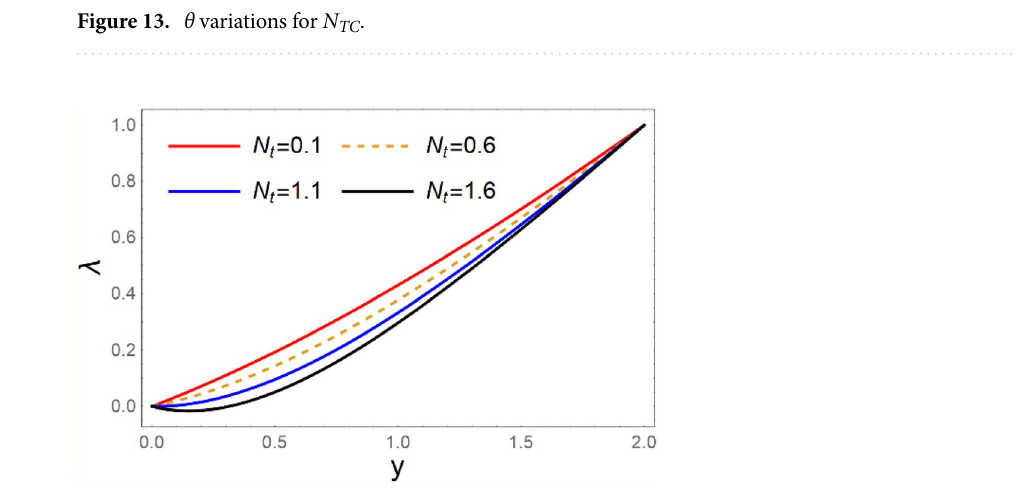
Figure 14. (cid:31) profile for N b .